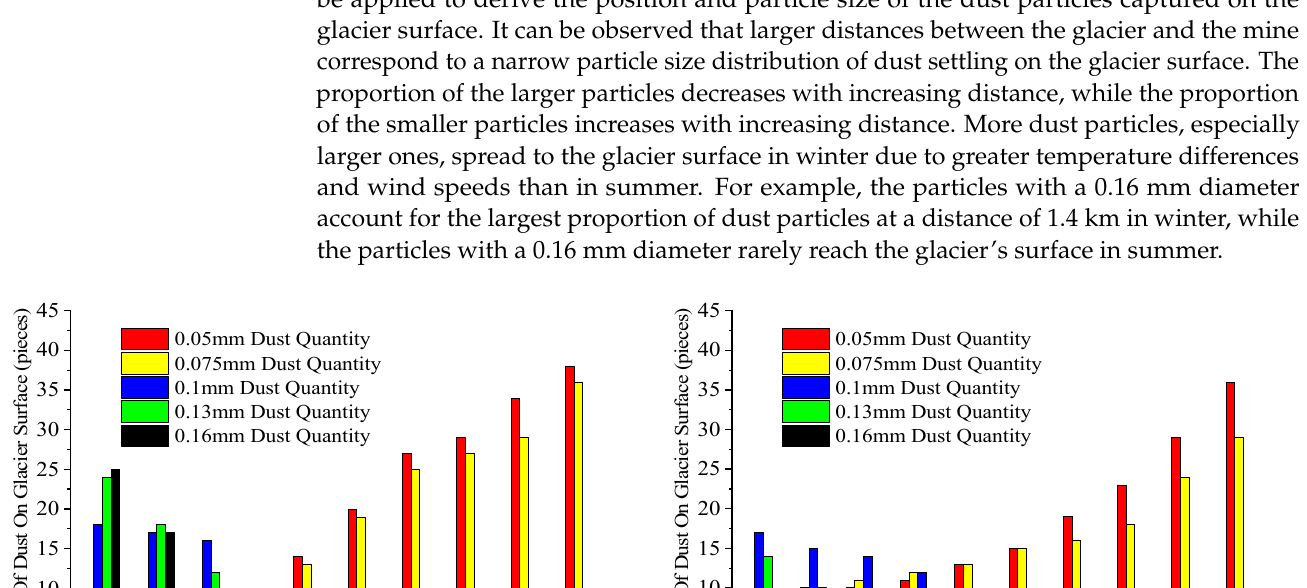
Figure 10. Spatial distribution of the mining dust on the glacier surface in ( a ) winter and ( b ) summer.